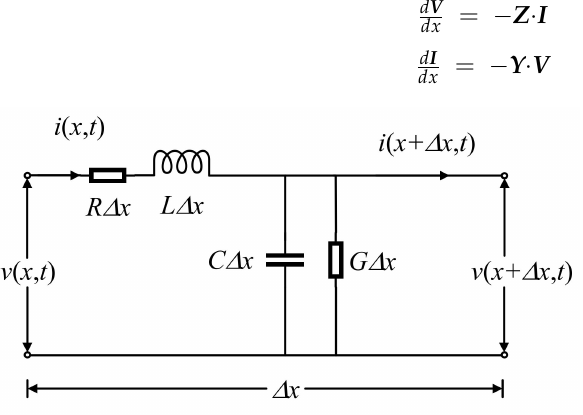
Figure 2. A two-port distributed parameter circuit. In (1), V and I represent the voltage and current vectors of the transmission line at electrical distance, x , respectively. Z and Y represent the impedance and admittance vectors, respectively. According to the transmission line theory, transmission lines are generally equivalent to distributed parameters, as shown in Figure 2, where R , L , C , and G represent the resistance, inductance, capacitance, and conductance per unit length of the transmission line, respectively. In the frequency domain, the current I ( x ) and the voltage V ( x ) at the electrical distance, x , of the transmission line can be presented in